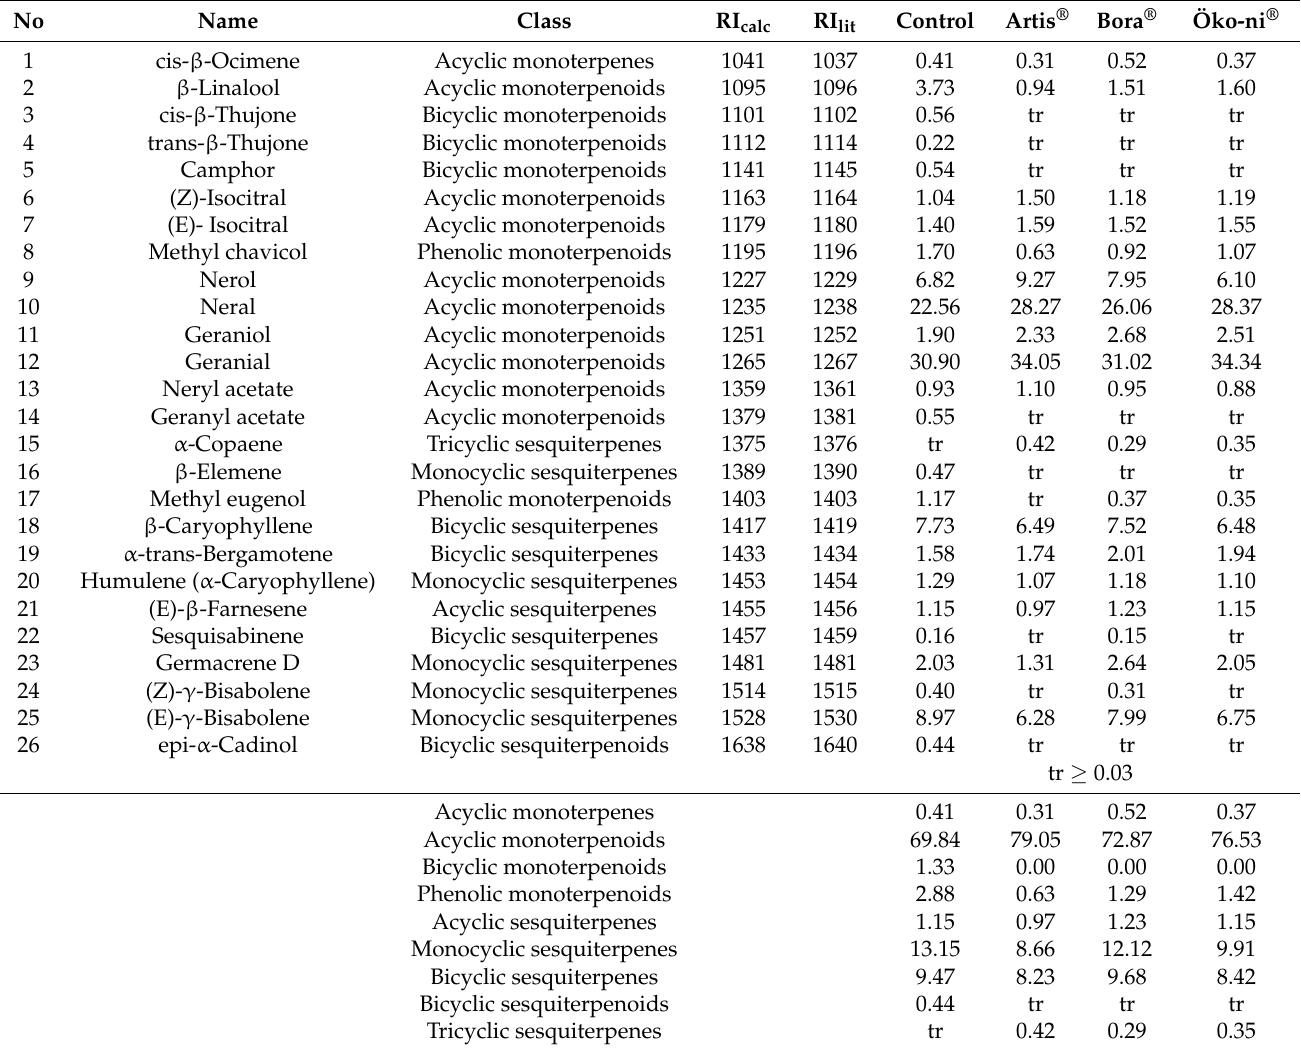
Table 6. Influence of myco-biocontrol formulates on essential oil composition of